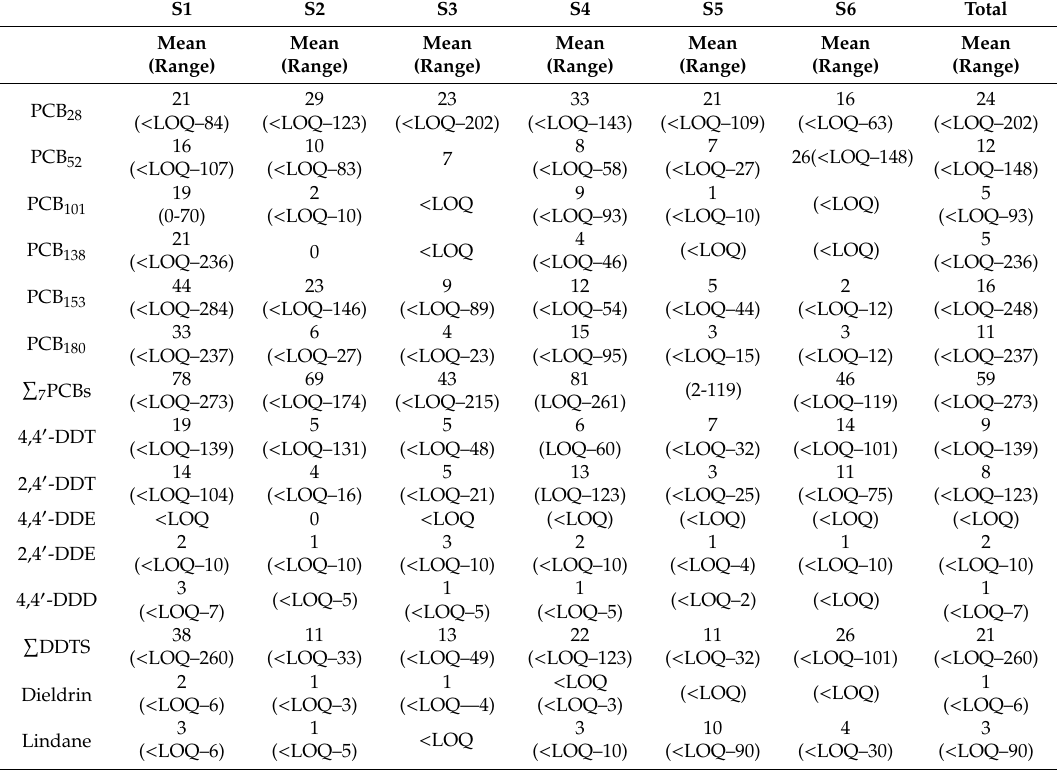
Table 1. Concentrations (ng / L) (mean and range) of POPs in water samples from Stations 1–6 of Talar